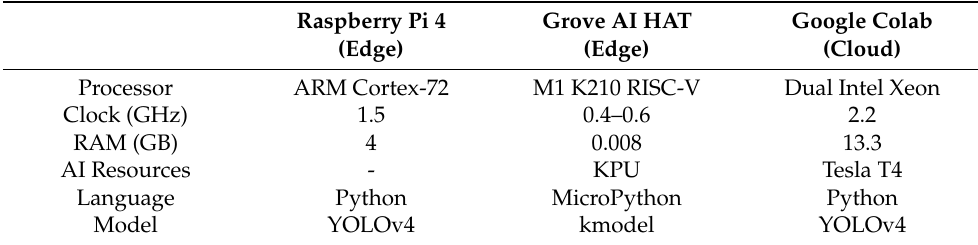
Table 5. Comparison of detection models between edge and cloud